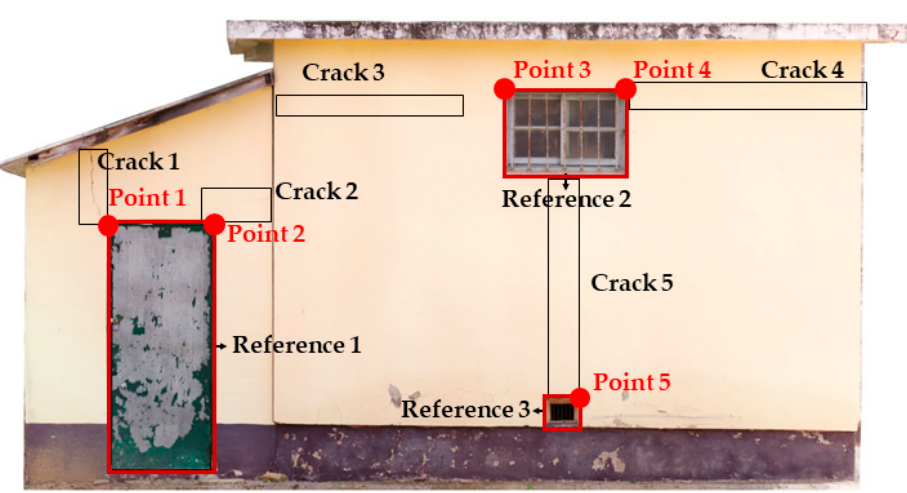
Figure 7. Analysis data after image rectification.